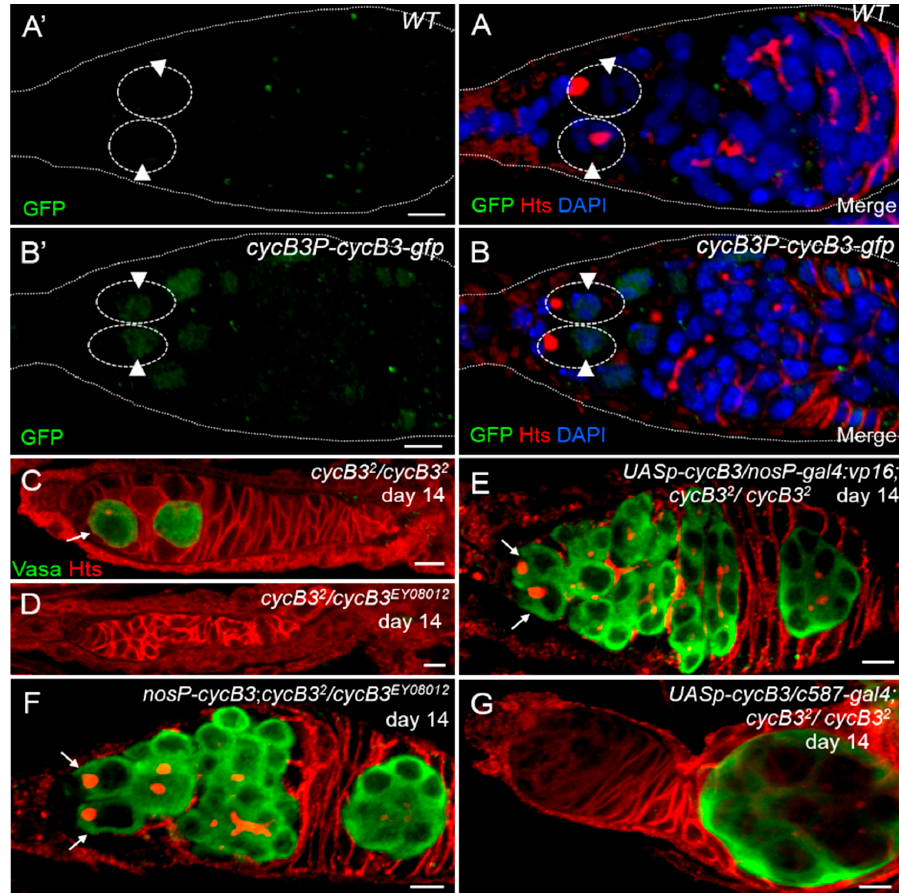
Figure 2. cycB3 is required intrinsically for controlling the fate of GSCs. ( A , B ) Ovaries were stained with anti-Hts antibody (red) to visualize fusomes, 4',6-diamidino-2-phenylindole (DAPI) dye to label nuclei (blue), and anti-GFP antibody (green) to show the cycB3 expression pattern; ( A’ , A ) Ovary from an Oregon fly (wild-type). GSCs (indicated by dashed circles) were GFP negative (noted by arrowheads); ( B’ , B ) Ovary carrying a transgene P{ cycB3P-cycB3-gfp }. GSCs (indicated by dashed circles) were GFP positive (green, noted by arrowheads); ( C – G ) Fourteen-day-old germaria stained with anti-Vasa antibody (green, germ cells), and with anti-Hts antibody (red, spectrosomes and fusomes). GSCs are indicated by arrows. ( C ) cycB3 mutant germarium with one GSC; ( D ) cycB3 mutant with empty germarium. ( E , F ) cycB3 mutant ovaries were rescued by the transgenes of nos-gal4:vp16 ; UASp-cycB3 and nosP-cycB3 . Germarium with two GSCs. ( G ) cycB3 mutant flies, carrying the genotype, c587-gal4 ; UASp-cycB3 . Ovary with an empty germarium. Scale bars: 5 μ m.